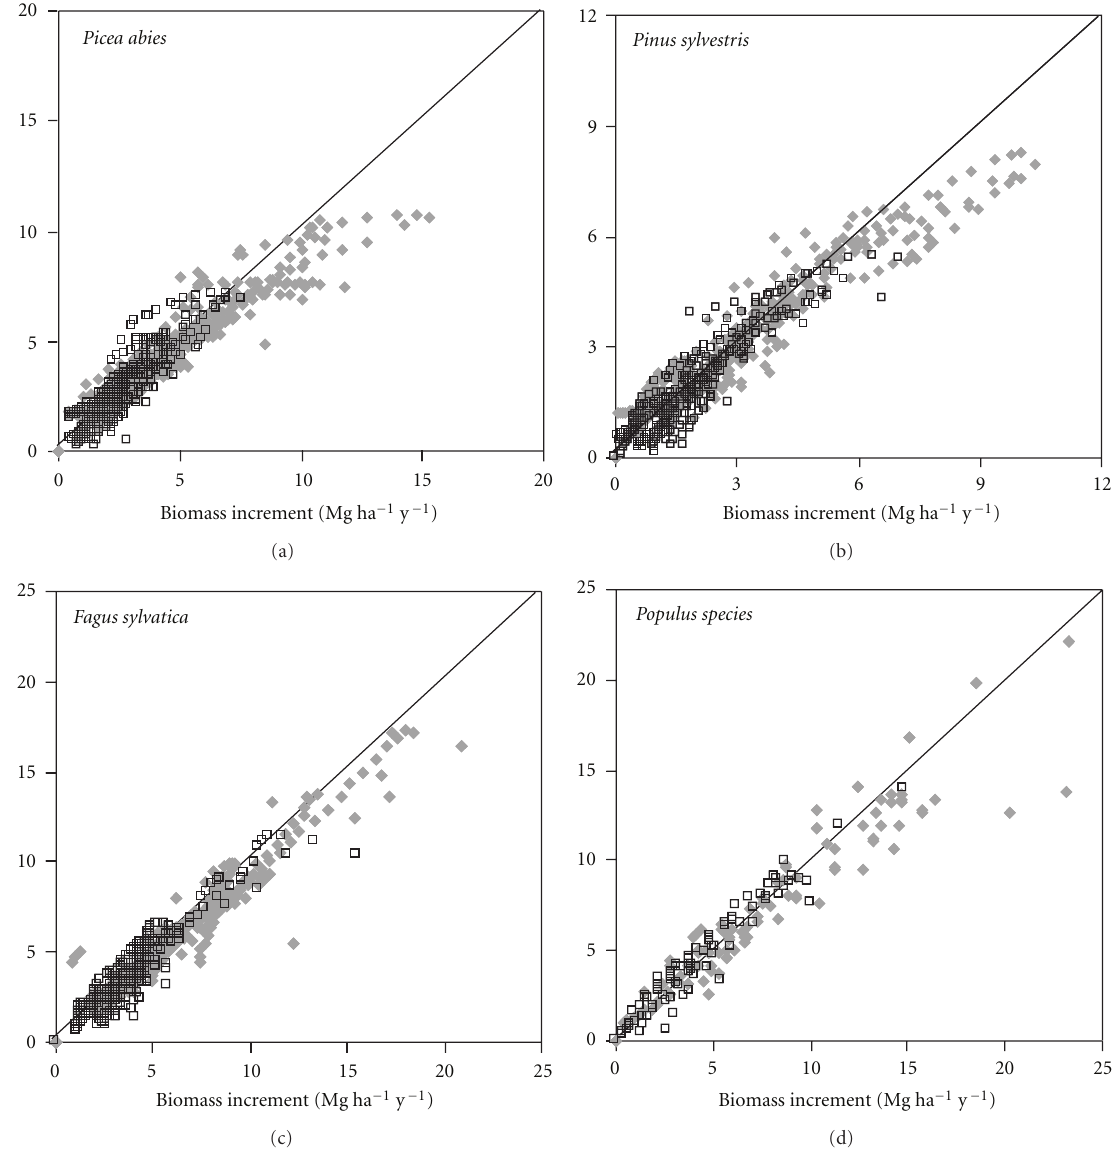
Figure 4: Measured yield table data ( x -axis) versus modeled ( y -axis) net biomass increment ( dB/dt , open black squares) and gross increment ( dB/dt g , closed grey symbols). r 2 values are shown in Table